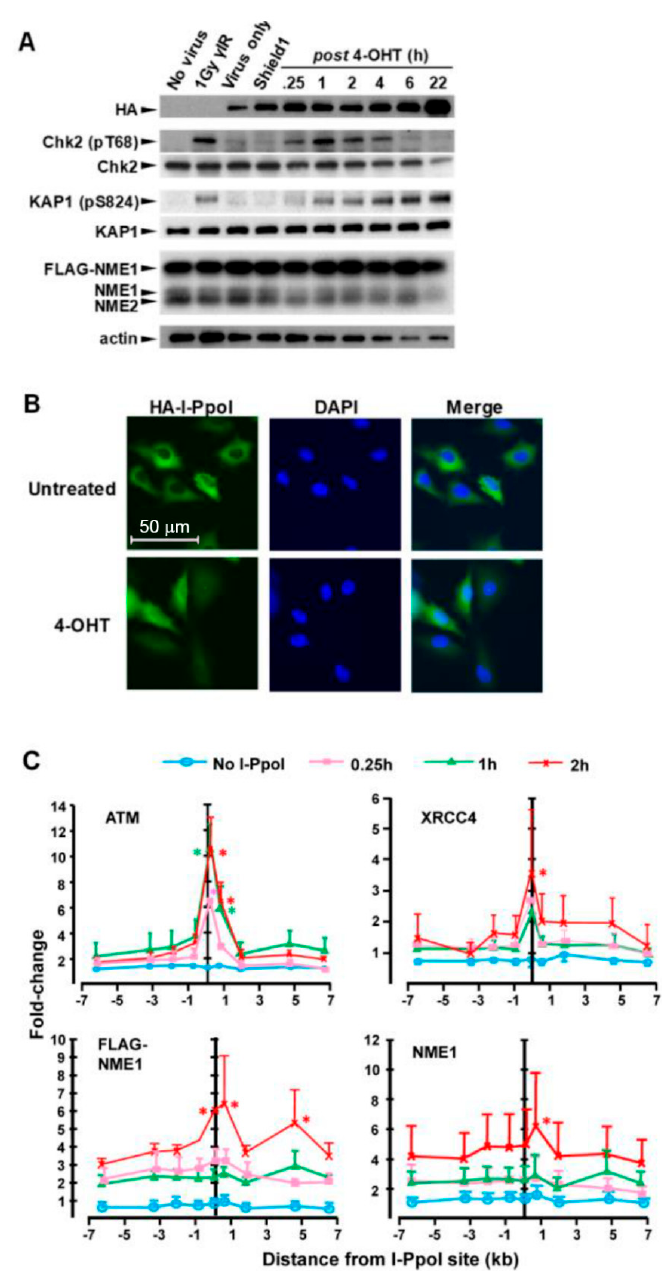
Figure 3. NME1 is recruited rapidly to DSB sites and adjacent regions of chromatin. ( A ) WM793-FLAG-NME1 cells were infected with a lentivirus (HA-ER-ddI-PpoI) harboring an HA-ER-IPpoI cassette tagged with a destabilization domain (dd) [34]. Infected cells were serum-starved for 24h to enrich for cells in the G1 phase of the cell cycle, followed by treatment with Shield-1 to promote cytoplasmic accumulation of I-PpoI protein. Cells were then treated for 15 min with 4-OHT (1 mM) to initiate nuclear translocation and DSB-inducing activity of I-PpoI. Immunoblot analysis was conducted with the indicated antibodies on cell lysates obtained at the indicated times after 4-OHT treatment. ( B ) 4-OHT induces nuclear translocation of I-PpoI-ER-DD-HA fusion protein. ( C ) Cells were fixed at the indicated time points after I-PpoI induction and ChIP performed with the indicated antibodies. qPCR was conducted with nine different primer sets directed to amplicons spanning the 28S RNA target site ( +/ − 6 kb). 1Gy of γ -IR was used as a positive control for response to DSB induction. Data points represent the mean + SEM of three independent experiments. Asterisks denote data points that are significantly di ff erent from untreated at time point of corresponding color at specific primer set, or in legend across all primers. p ≤